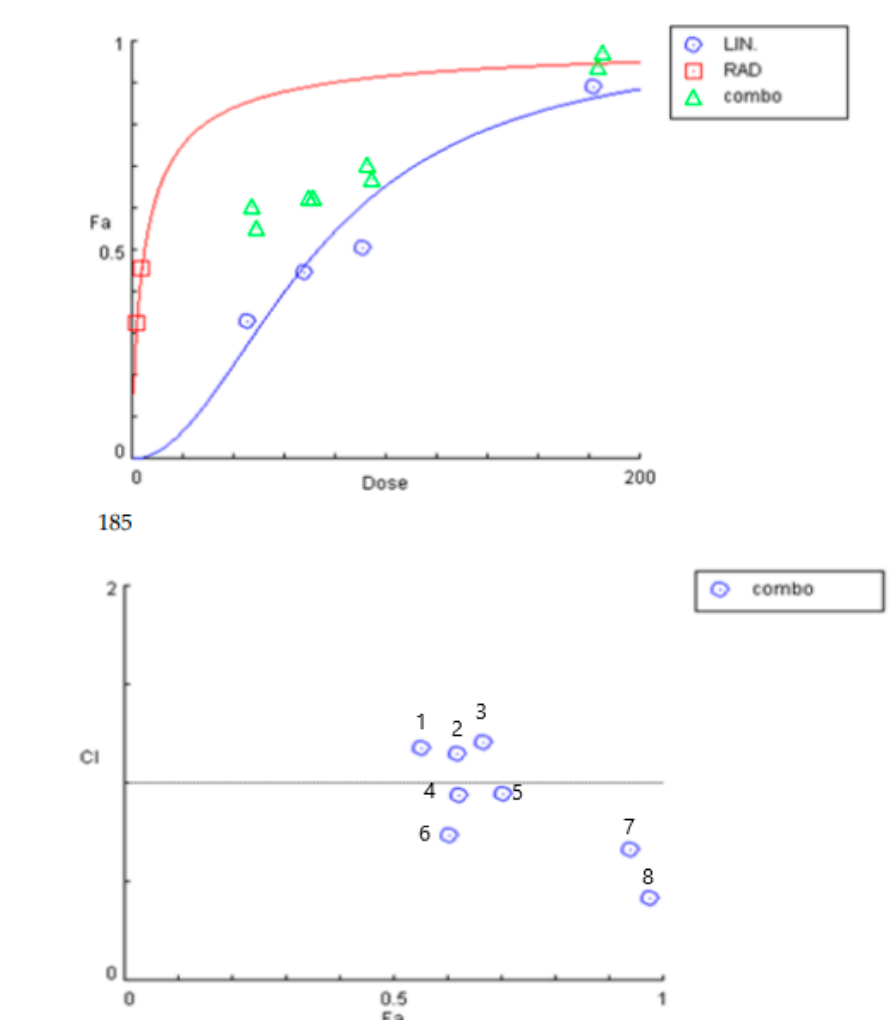
Figure 6. Determination of the synergistic effect of the treatment of linearol with radiation on T98 cells. ( a ) Dose–response curve of linearol and radiotherapy. Combo indicates the different combinations of linearol and radiation. ( b ) Combination index (CI) plot for all combinations. CI = 1 defines additive effect, CI < 1 defines synergism, whereas CI > 1 is antagonism. Numbers refer to different combinations used in the experiment. 1 = Lin 45.5 µ M + Rad 4 Gy, 2 = Lin 68 µ M + Rad 4 Gy, 3 = Lin 91 µ M + Rad 4 Gy, 4 = Lin 68 µ M + Rad 2 Gy, 5 = Lin 91 µ M + Rad 2 Gy, 6 = 45.5 µ M + Rad = 2 Gy, 7 = Lin 182 µ M + Rad 2 Gy, 8 = Lin 182 µ M + Rad = 4 Gy.